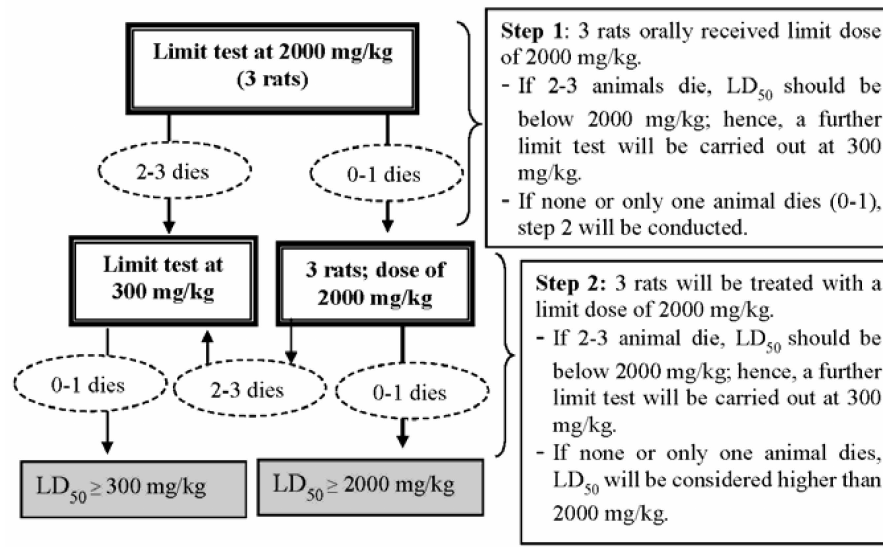
Figure 1. Acute toxicity chart